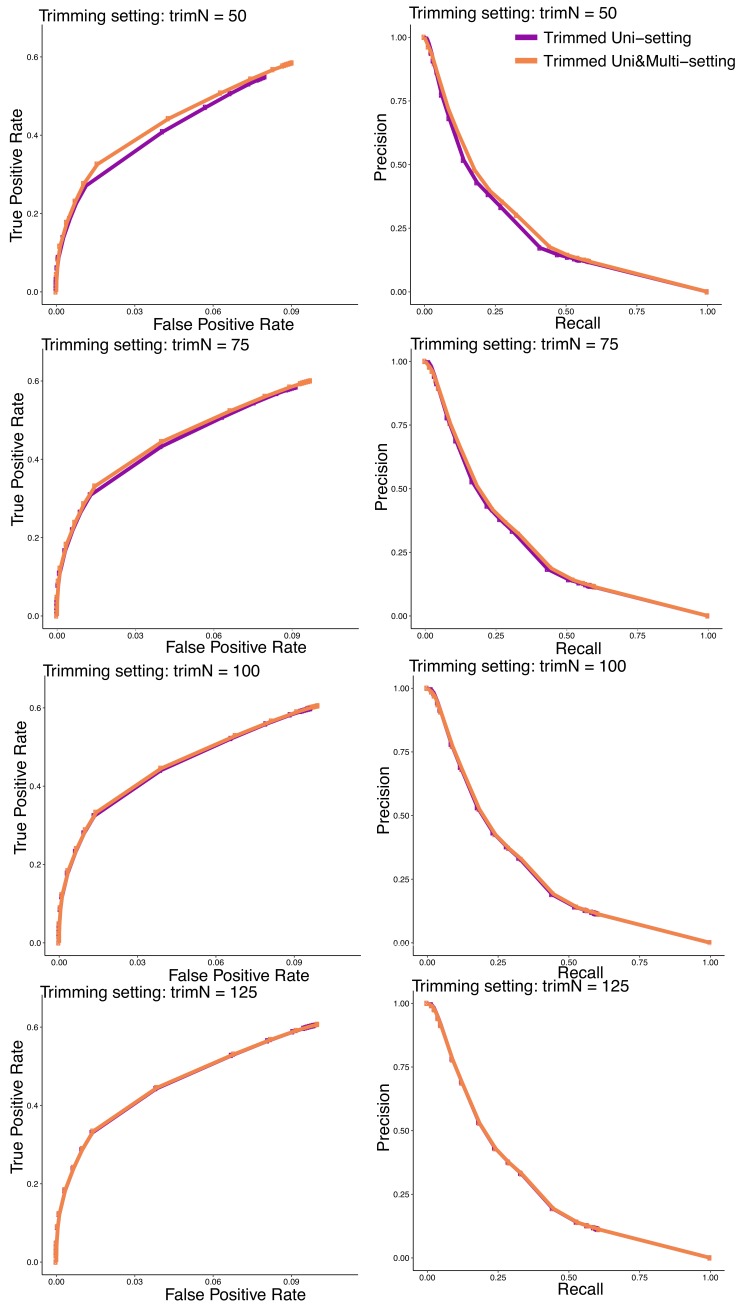
ROC and PR curves for detection of full read length dataset significant interactions by the analysis of trimmed read datasets under the trimmed Uni- and Uni&Multi-settings at read lengths of 50 bp, 75 bp, 100 bp, and 125 bp.In the ROC curves, the false positive rates are displayed up until 10% as the values of both the x- and y-axis rates shoot up to one after this value. Ground truth for these curves is based on the significant interactions identified by the full read length dataset at FDR of 10%.